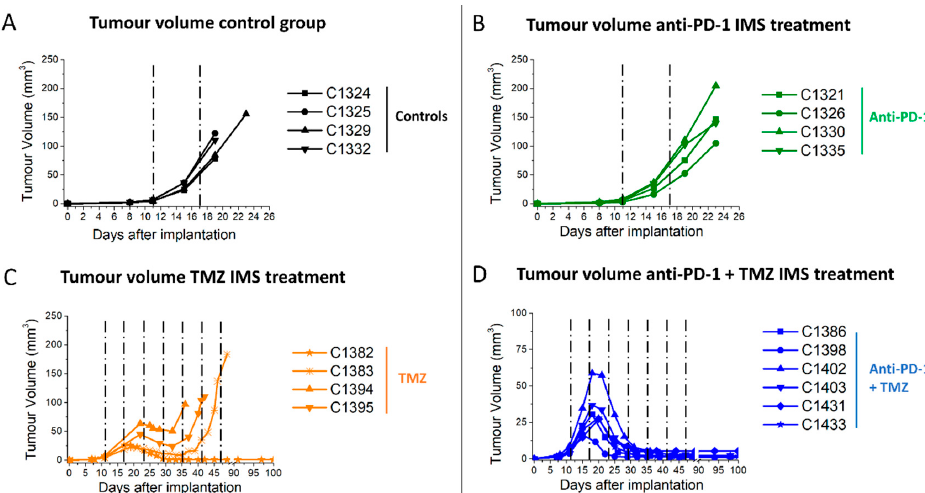
Figure 1. Tumour volume evolution of mice in monotherapy and combination therapy groups. ( A ) Tumour volume evolution of mice treated with ( A ) control isotype murine immunoglobulin G (IgG) in immune-enhancing metronomic schedule (IMS) ( n = 4, black lines); ( B ) anti-PD-1 in IMS ( n = 4, green lines); ( C ) Temozolomide (TMZ) alone in IMS ( n = 4, orange lines); and ( D ) anti-PD-1 combined with TMZ in IMS ( n = 6, blue lines). The black dashed lines indicate therapy administration time points. Cxxxx corresponds to a unique alpha-numeric animal identifier code in the Grup d'Aplicacions Biomèdiques de la Ressonància Magnètica Nuclear (GABRMN) group.